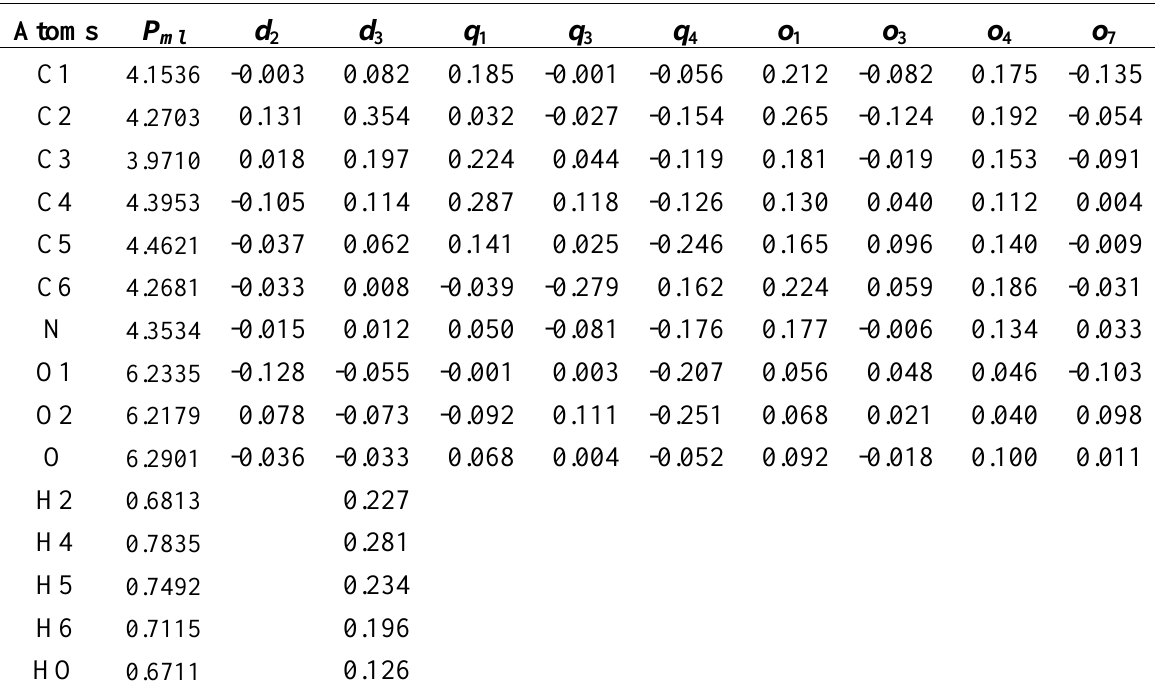
Table 3. The multipolar coefficients as described in the model of Hansen & Coppens. Pv correspond to l=0. d and d correspond to l =1(d1=0) and q , q and q are the quadrupolar coefficients 2 3 1 3 4 corresponding to l=2 (q =q =0). o , o , o and o are the octapolar coefficients corresponding to l=3 in 2 5 1 3 4 7 =o =o =0). Some coefficients are set equal to zero because of atomic the multipolar development (o 2 5 6 sites